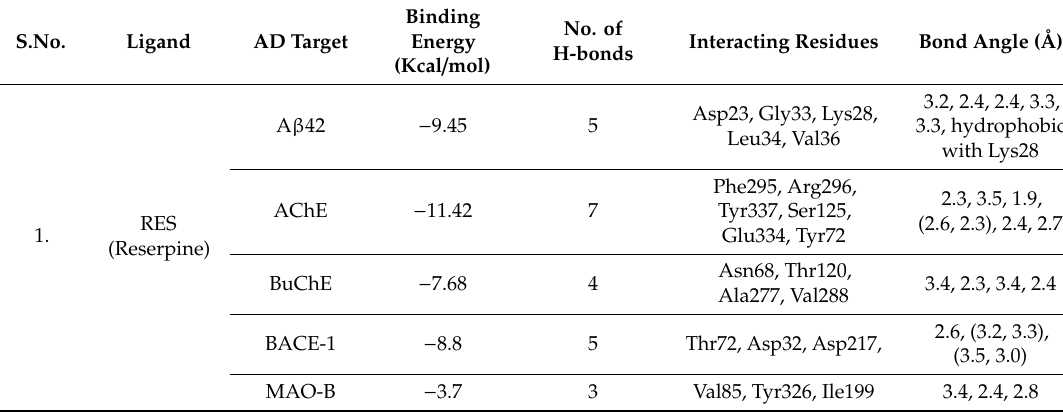
Table 5. Molecular interactions as observed in ligand docked complexes of target receptor proteins obtained from Autodock 4.2.